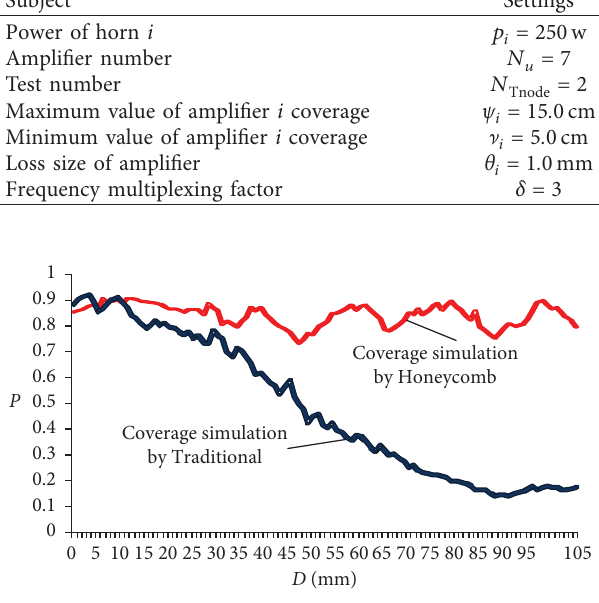
Figure 5: Coverage comparison of simulation in new and tradi- tional ultrasonic vibration